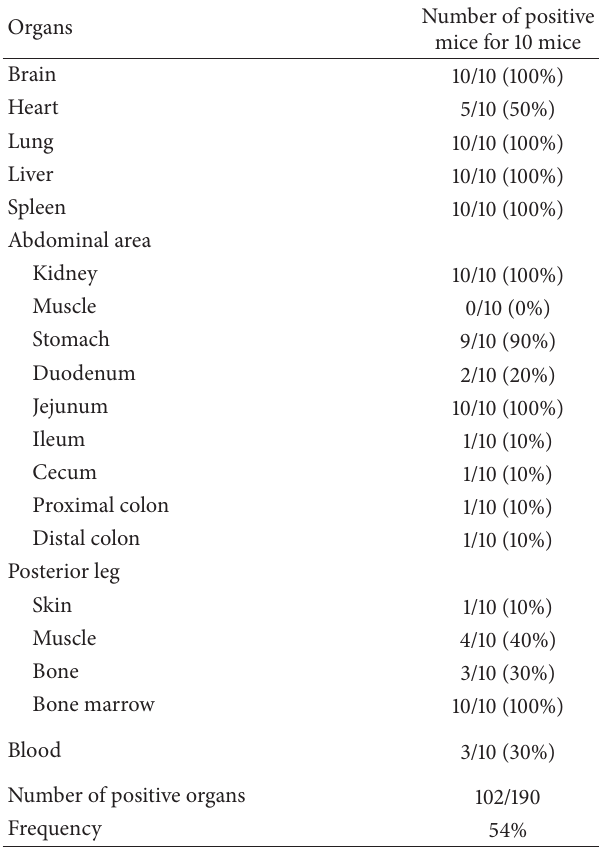
Table 1: hMSC engraftment in nonirradiated mice 3 days after